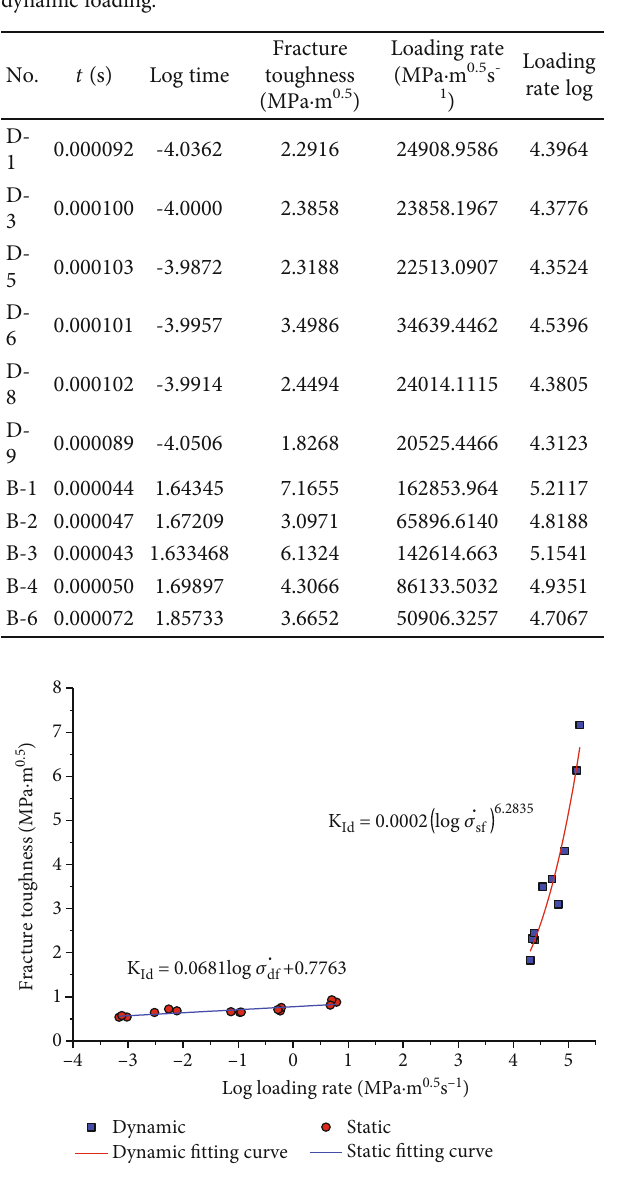
Figure 6: Comparison of the fracture toughness under dynamic and static loading.